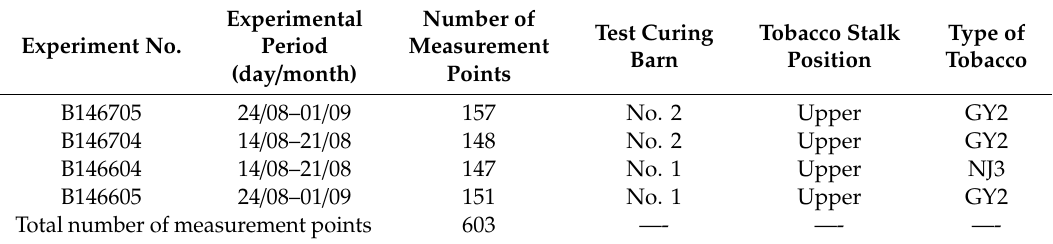
Figure 5. Inside of the curing barn loaded with tobacco. Table 2. Data sets.